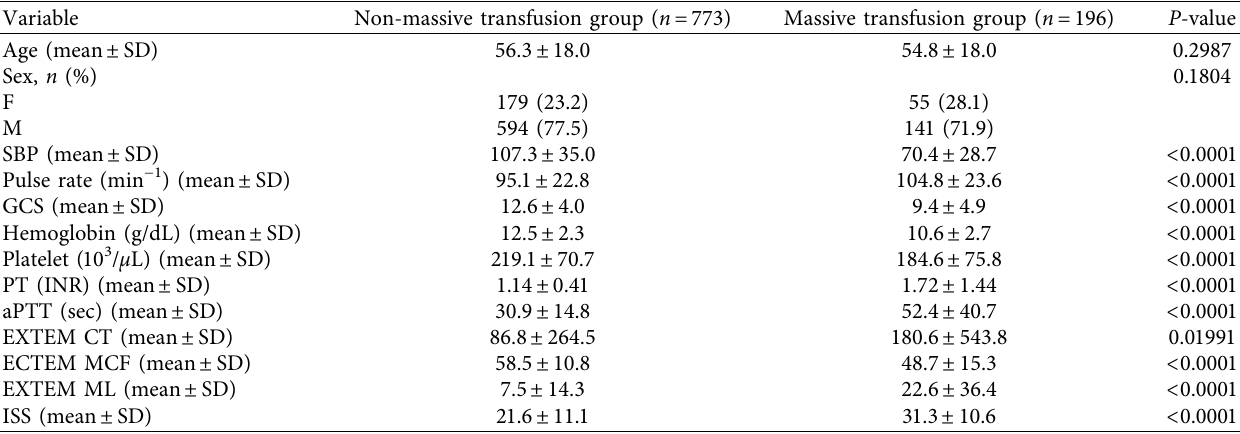
Table 2: Comparison of clinical characteristics and outcomes between non-massive transfusion groups and massive transfusion groups. SD: standard deviation; SBP :Systolic blood pressure; GCS :Glasgow coma scale; PT (INR): prothrombin time (international normalized ratio); aPTT: activated partial thromboplastin time; CT: clotting time; MCF: maximum clot firmness; ML: maximum lysis; ISS: injury severity